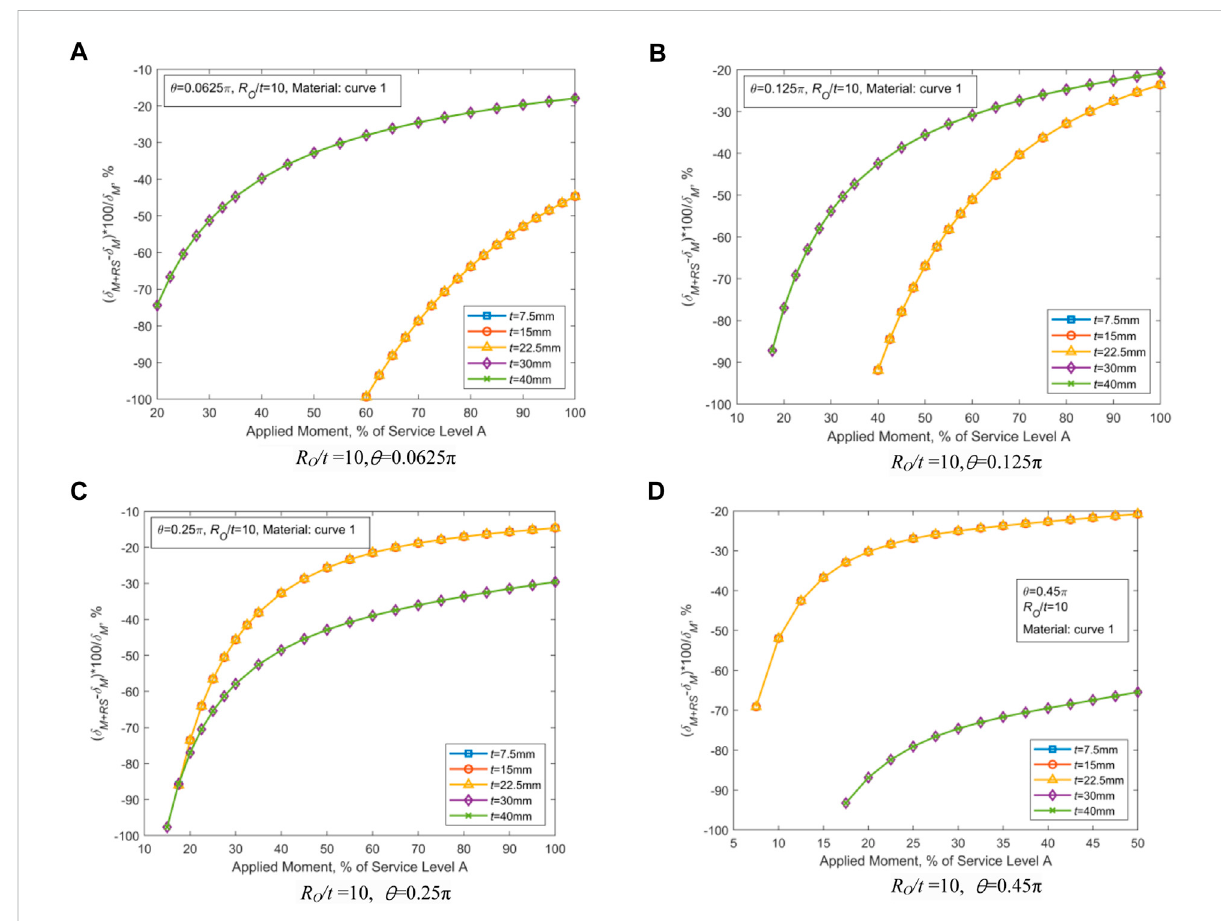
FIGURE 4 Effect of WRS on the external wall ’ s COD. (A) R O /t = 10, θ = 0.0625 π . (B) R O /t = 10, θ = 0.125 π . (C) R O /t = 10, θ = 0.25 π . (D) R O /t = 10, θ = 0.45 π